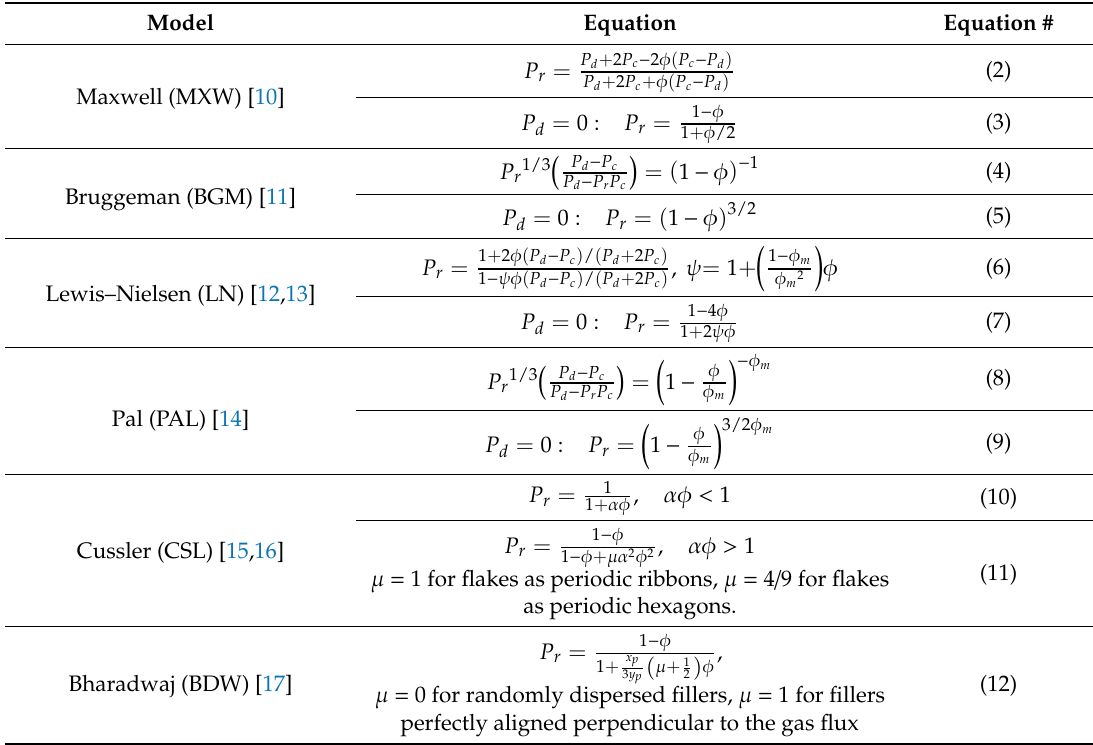
Table 1. Predictive models for the relative permeability ( P r ) of a migrating species in a mixed-matrix membrane (MMM) with nanoparticles